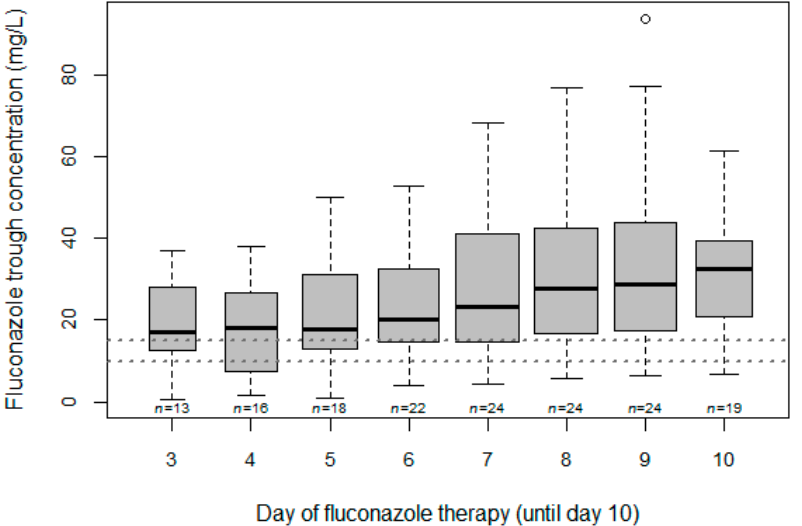
Figure 2. Boxplot of fluconazole trough concentrations during the first 10 days of fluconazole ther- apy ( n = 160). The boxes represent the median and IQR. The horizontal lines depict the 10 and 15 mg/L thresholds.